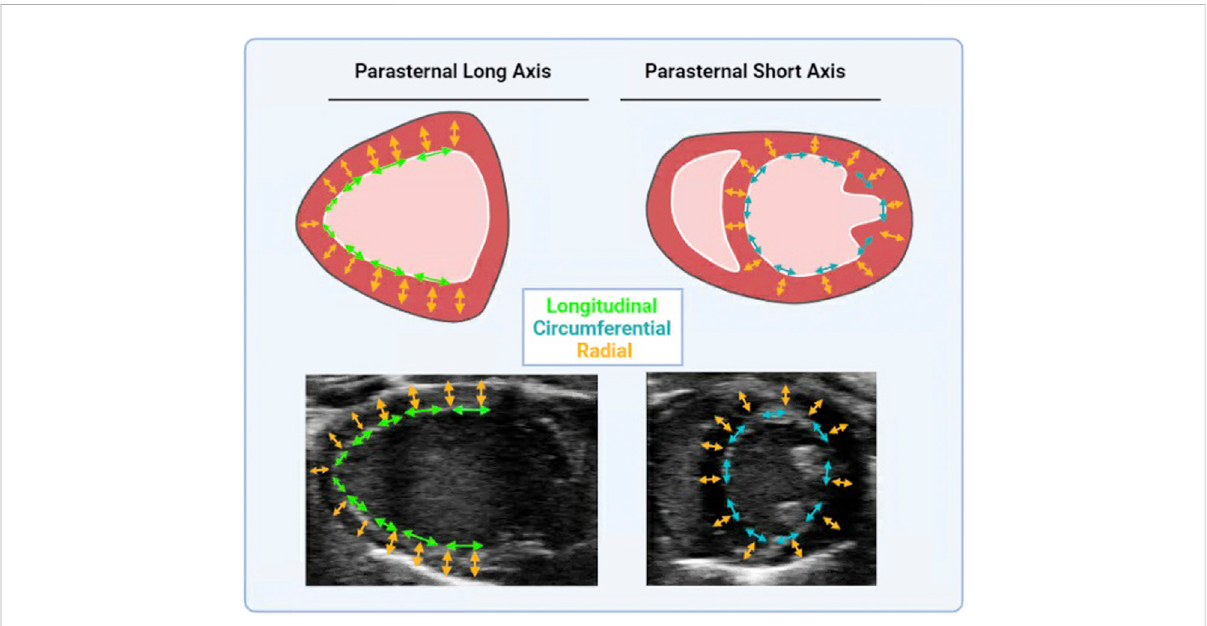
FIGURE 2 Directional vectors of Cardiac Strain. Cardiac strain is measured in parasternal long axis and short axis. Long axis cine loops provide long axis radial (in yellow arrows) and longitudinal strain (in green arrows). Short axis cine loops provide short axis radial (in yellow arrows) and circumferential strain (in red arrows). Cartoon and anatomical views are